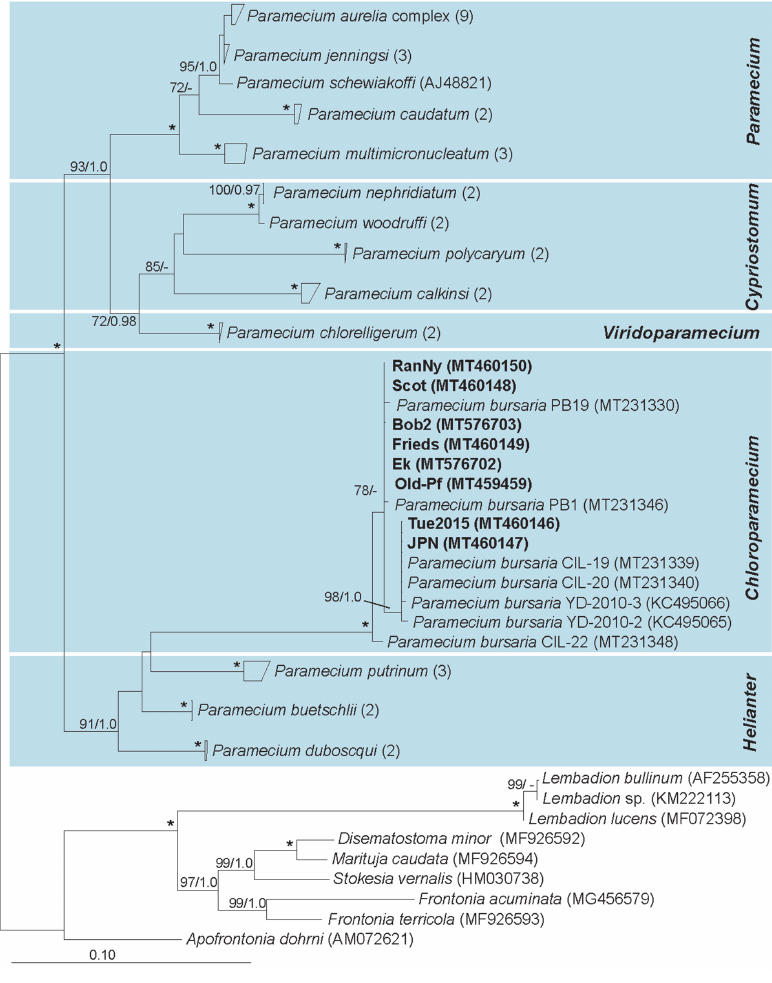
Figure 3. Molecular phylogeny of the genus Paramecium based on SSU rRNA gene sequences. Maximum likelihood tree based on 1493 aligned positions. GTR + I + G was used as evolutionary model. The respective subgenera are highlighted. Other members of Peniculida were used as outgroup. Bootstrap values above 70% and Bayesian Interference values above 0.95 are indicated. Asterisks indicate maximum support in both analyses. Numbers in brackets represent the number of sequences included in collapsed groups. Sequences marked in bold were obtained in this